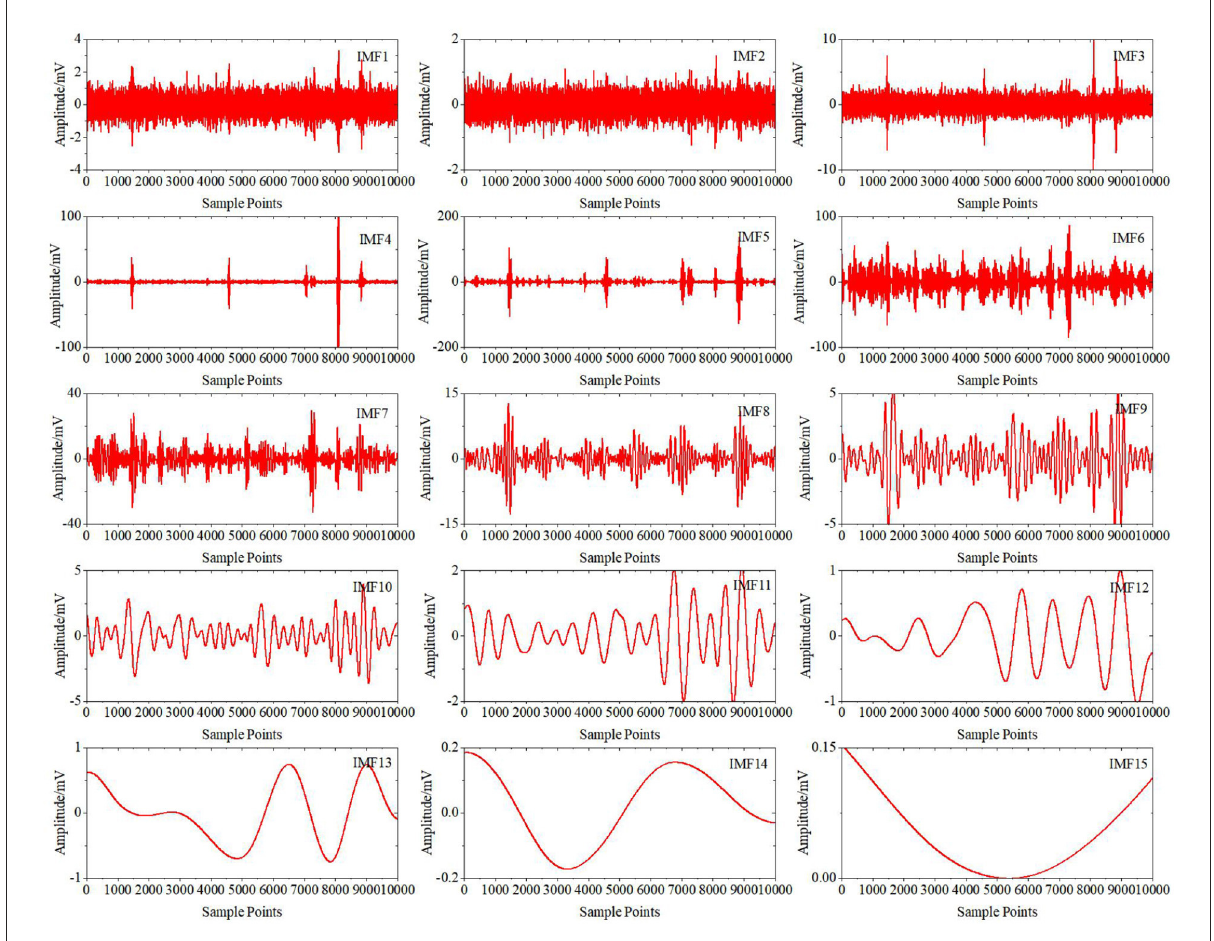
FIGURE7 CEEMDAN decomposition results on high-frequency detail coefficient